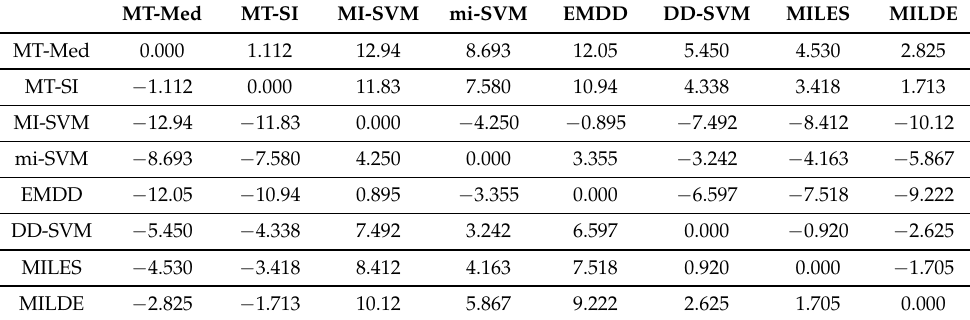
Table 16. Contrast Estimation between the methods on each row with respect to the methods on each column, considering different datasets. Positive values indicate that the method in the row presented higher average accuracy than the method in the column. The proposed methods are MILTree-Med (MT-Med) and MILTree-SI (MT-SI).